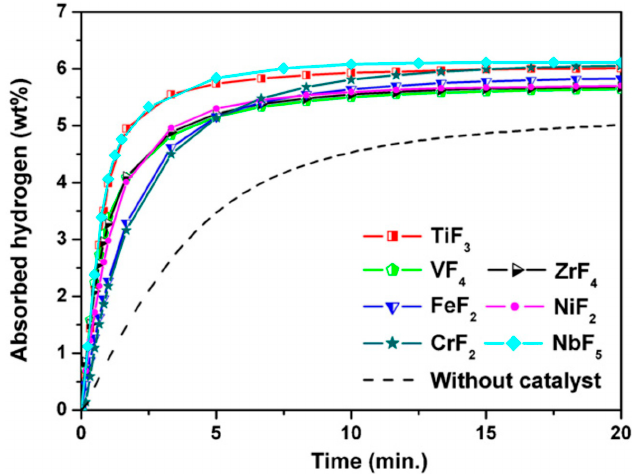
Figure 2. Hydrogenation kinetics of MgH 2 at 573 K under 10 bars of hydrogen with 1 mol% transition metal fluorides [129].